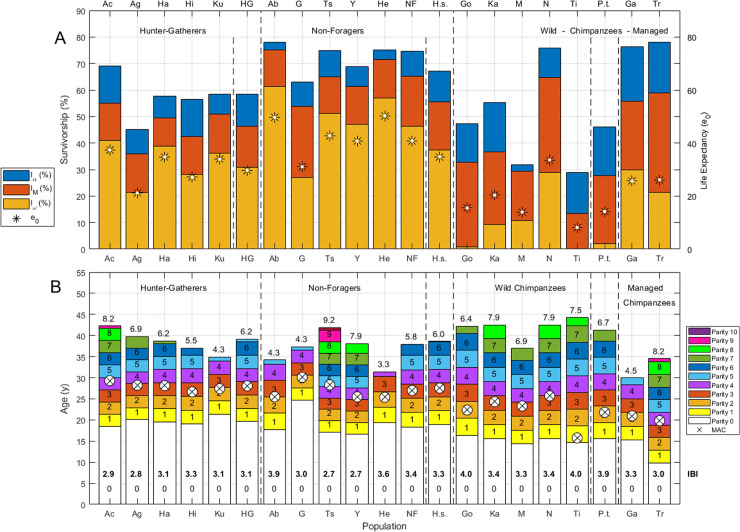
Summary of demographic measures for chimpanzee and human populations.(A) Stacked bars indicate survivorship (%) to maturity (lα), to mean age of reproduction (lM) and to maximum age of reproduction (lω); life expectancy (e0) is indicated by a large asterisk. (B) Stacked bars indicate rough ages at each parity from zero (nulliparous) to the total fertility rate (TFR) estimated for each population. Parity is indicated by inset text in each stacked bar, TFR is indicated above each bar and the mean interbirth interval (IBI) is in bold text inset in the lowest (nulliparous) bar. Vertical dashed lines separate Hunter-gatherers (HG), Non-Foragers (NF) and Wild Chimpanzees (WC). Hunter-gatherers are labeled: Ac (Ache), Ag (Agta), Ha (Hadza), Hi (Hiwi), Ku (Ju/’hoansi! Kung), hunter-gatherer mean life history (HG). Non-foragers are labeled: Ab (Aborigines), G (Gainj), Ts (Tsimane), Y(Yanomamo), He (Herero), non-forager mean life history (NF). Chimpanzee populations are labeled: Go (Gombe), Ka (Kanyawara), N (Ngogo), Ti (Taï), wild chimpanzee mean life history (WC), Ga (Gambia), Tr (Taronga).